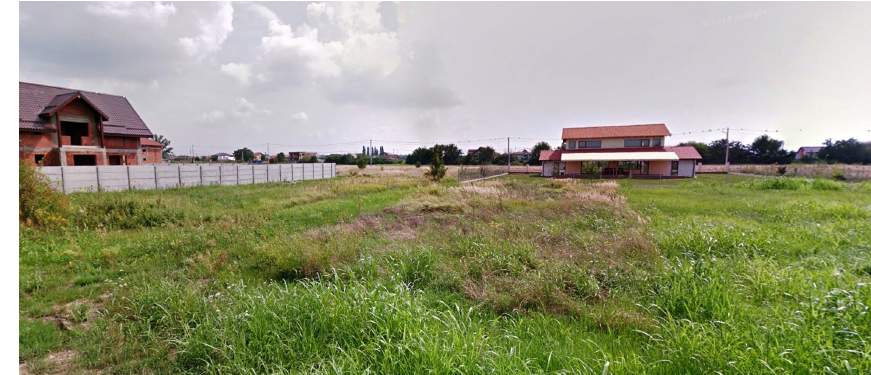
fig. 5a. Sprawl in the suburban zone of Timisoara in Romania. Dumbrăvita commune. Source: the authors.